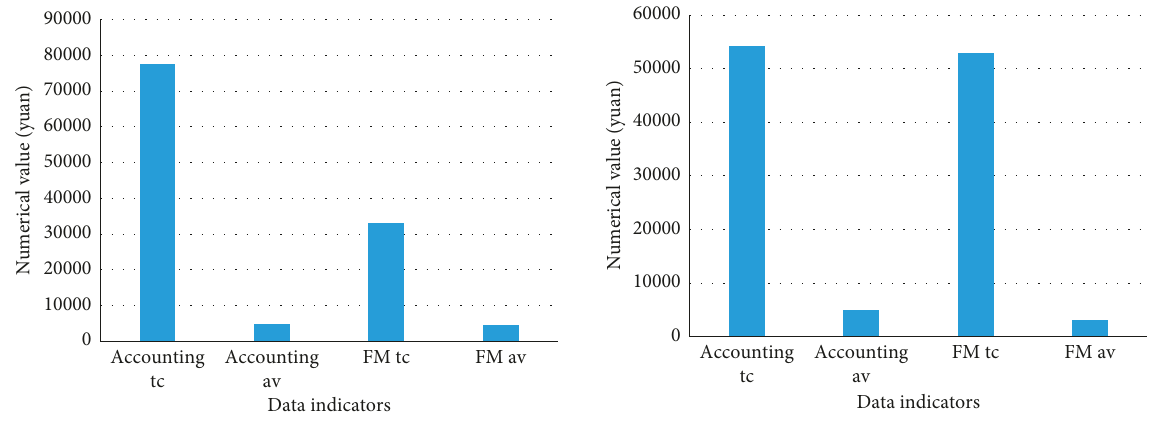
Figure 9: Experimental